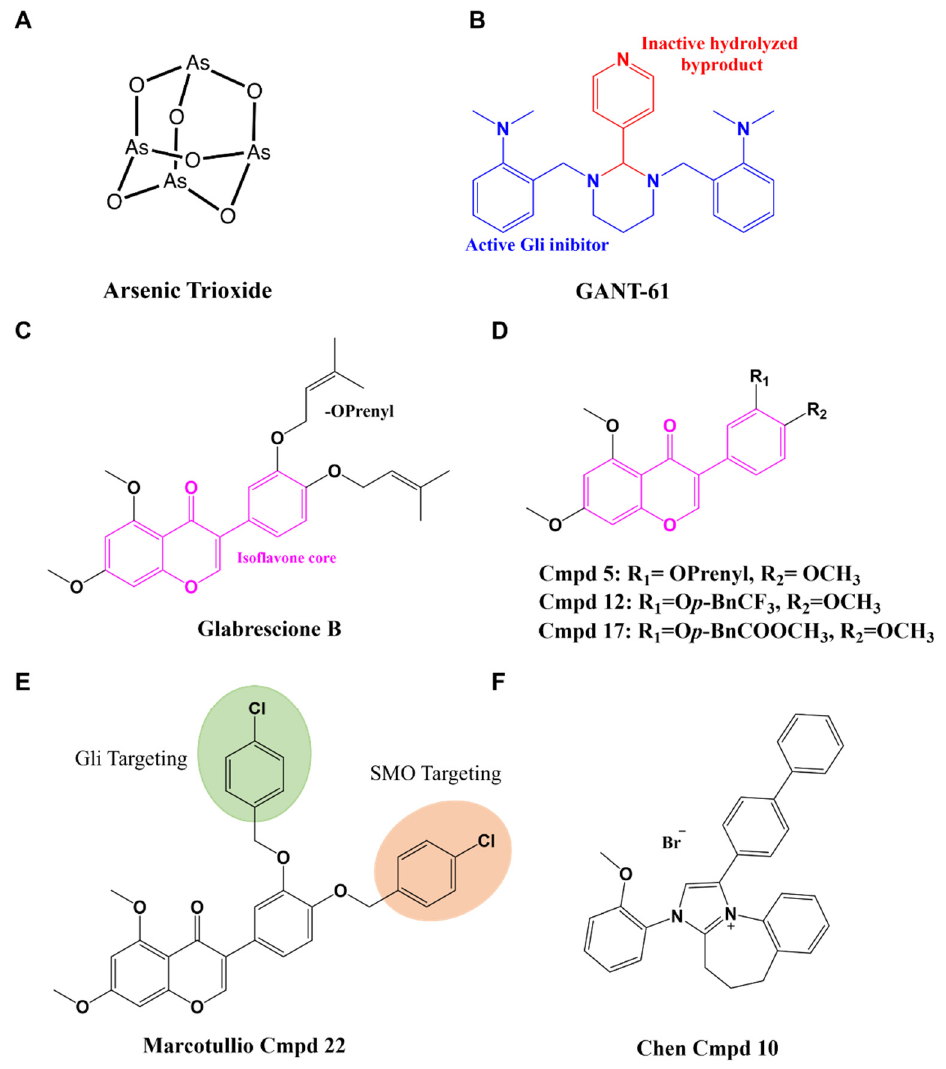
Figure 5. Chemical structures for small molecule Gli inhibitors. ( A ) Arsenic trioxide downregulates Gli activity but is unknown to bind directly. ( B ) GANT-61 is the gold standard for direct Gli inhibition. In aqueous solution, it undergoes hydrolysis to unmask the active inhibiting scaffold. ( C ) Glabrescione B binds directly to Gli in disrupt the DNA binding interaction. ( D ) Structural modifications to GlaB elucidate chemical modifications that maintain or prevent Gli inhibition ( E ) A dual-targeted compound that inhibits both SMO and Gli. ( F ) New bicyclic imidazolium derivatives inhibit Gli function but have unintended impacts on cellular health.